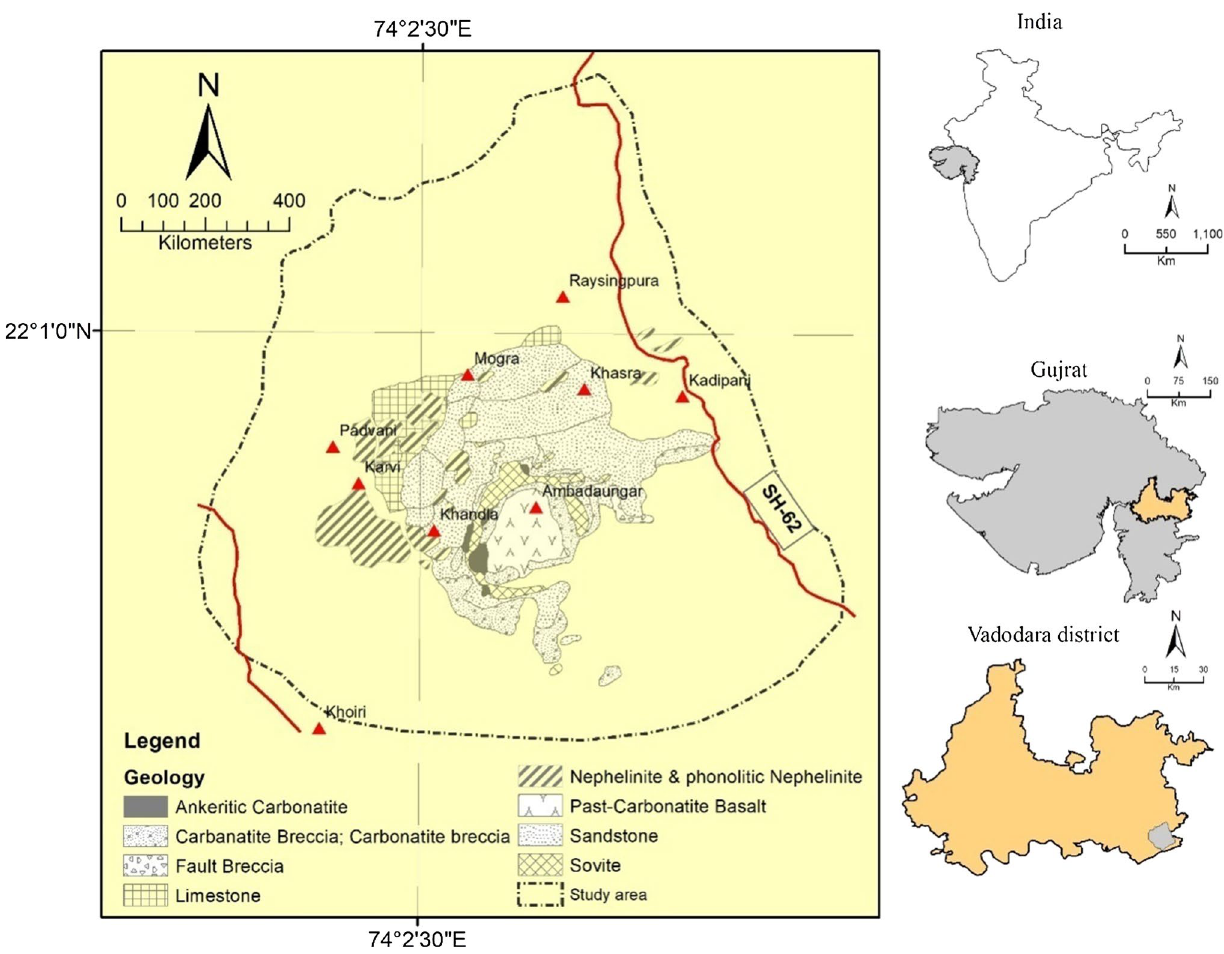
Fig. 1 Location and geology of study